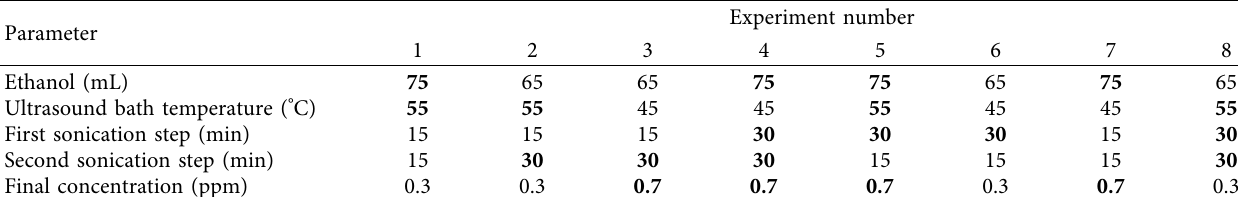
Table 6: Youden–Steiner design for selected variables of the